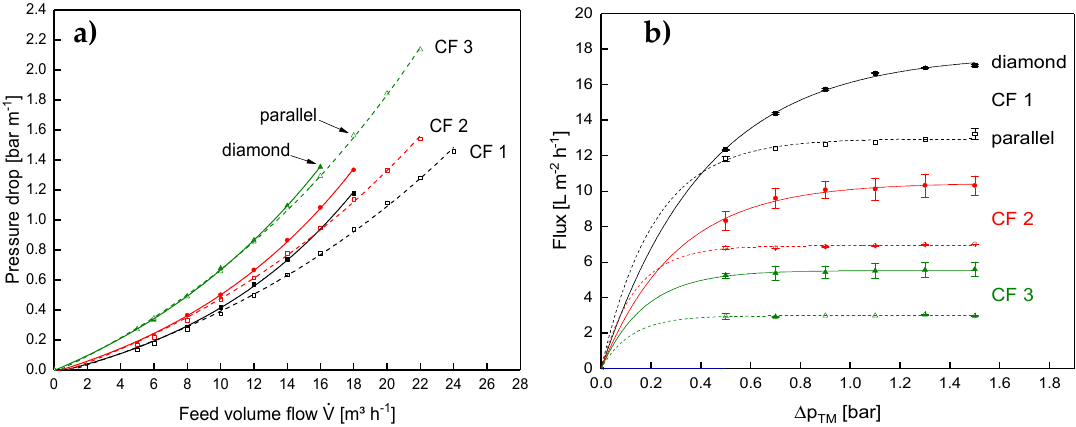
Figure 12. Axial pressure drop as a function of the feed volume flow ( a ) and flux as a function of the transmembrane pressure for the parallel and the diamond spacer in SWM during MF of skim milk at CF 1 to 3. Error bars in ( b ) represent the standard deviation of two individual experiments. Data on the diamond spacer were adapted from Hartinger and Kulozik [14].